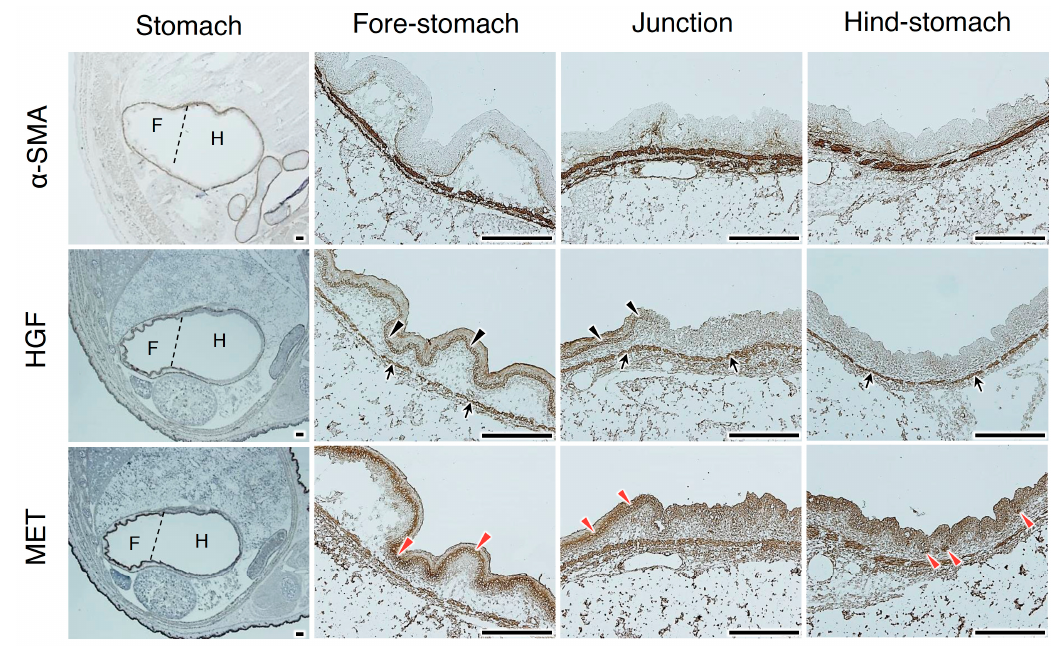
Figure 3. Localizations of HGF and MET receptors in the developing stomach. Immunohistochemical staining was performed using t5A11 anti-human HGF monoclonal antibody or anti-MET antibody. Stomachs in day 16.5 embryos were divided into the anterior/fore-stomach and posterior/hind-stomach, distinguished by dotted lines. Black arrows indicate HGF localization in smooth muscle cells. Black arrowheads indicate HGF localized in the epithelial cells. Red arrowheads indicate MET expression in epithelial cells. Similar localization patterns were obtained in sections from two different mice. Tissues were obtained from day 16.5 embryos of hHGF-ki mice. Scale bars represent 200 µm.